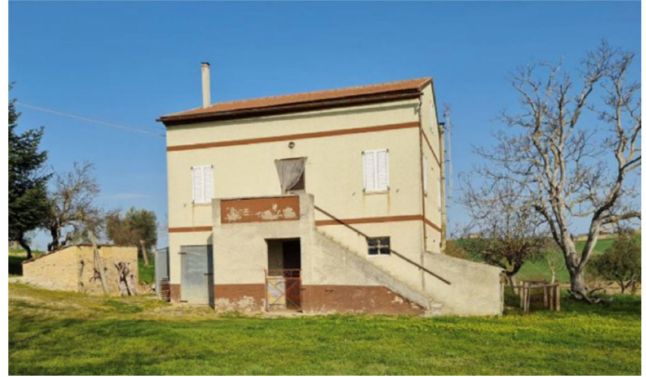
Figure 21. The case under